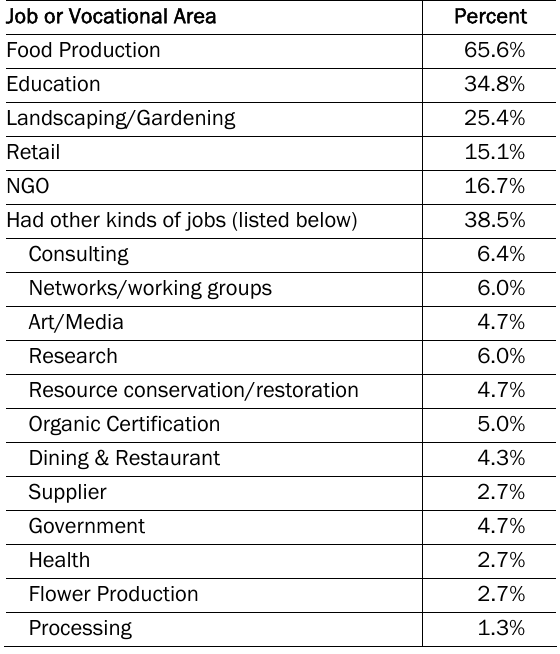
Table 3: Percent of people identified as working in the following areas, based on brief job descriptions